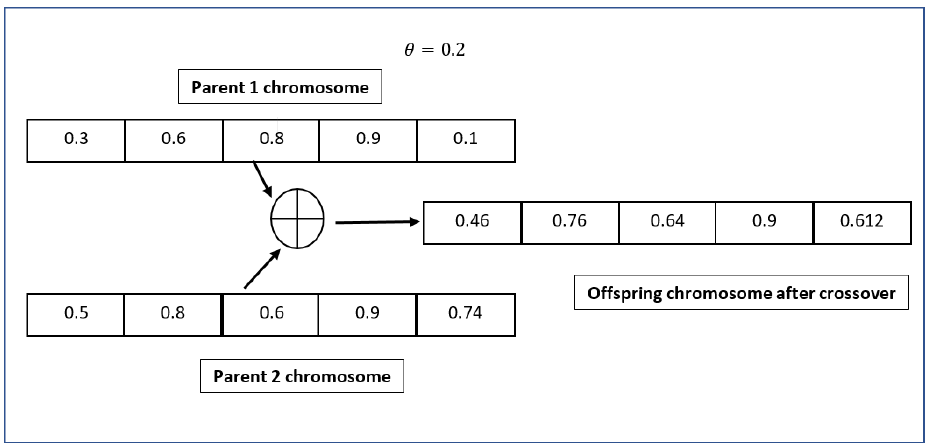
Figure 6. Crossover